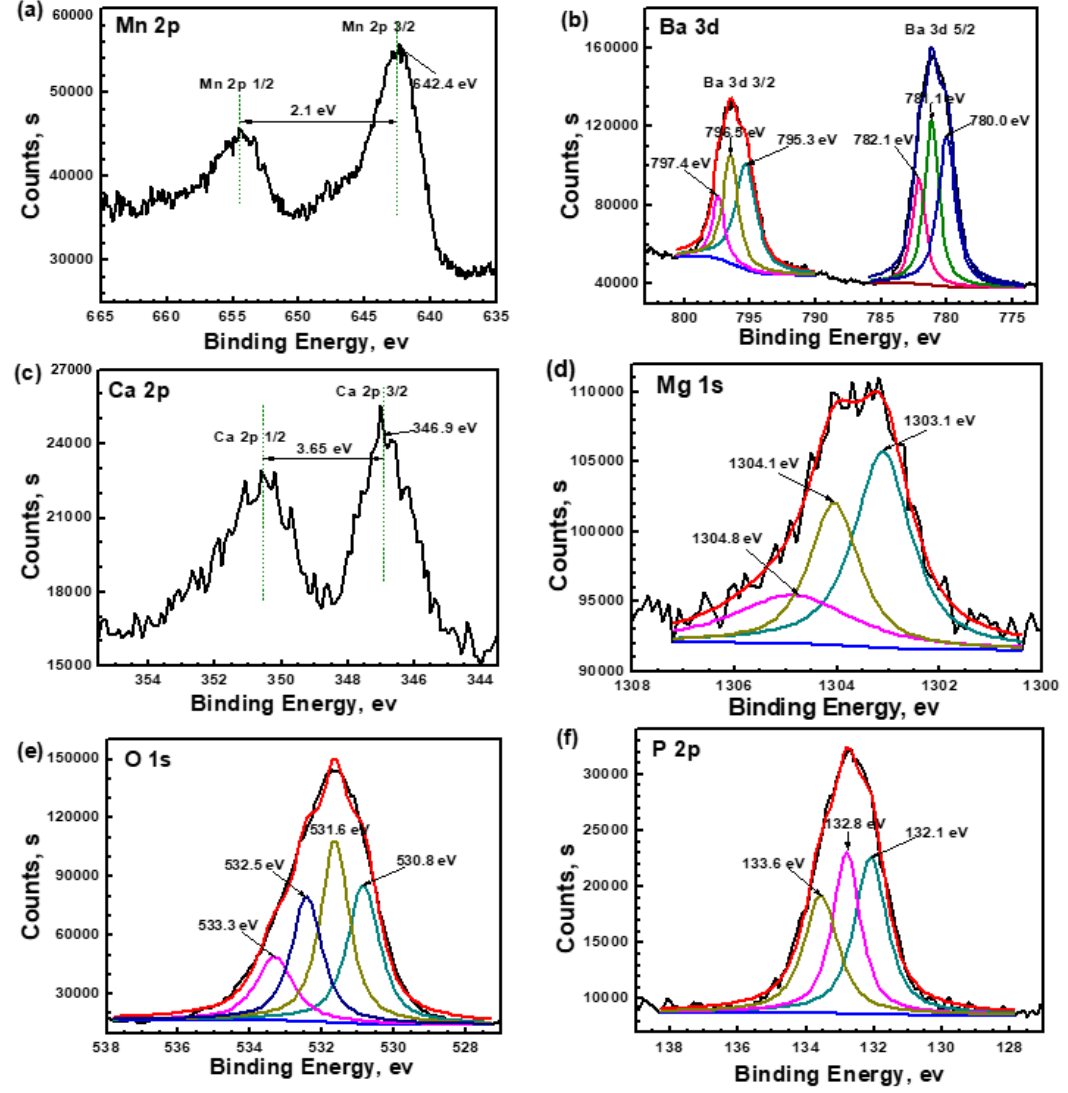
Figure 3. XPS analysis of the film after 30 s etching: ( a ) Mn 2p; ( b ) Ba 3d; ( c ) Ca 2p; ( d ) Mg 1s; ( e ) O 1s; and ( f ) P 2p.